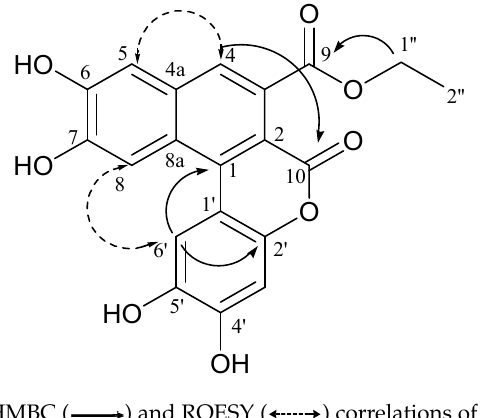
Figure 3. Key HMBC ( ) and ROESY ( ) correlations of compound 15.